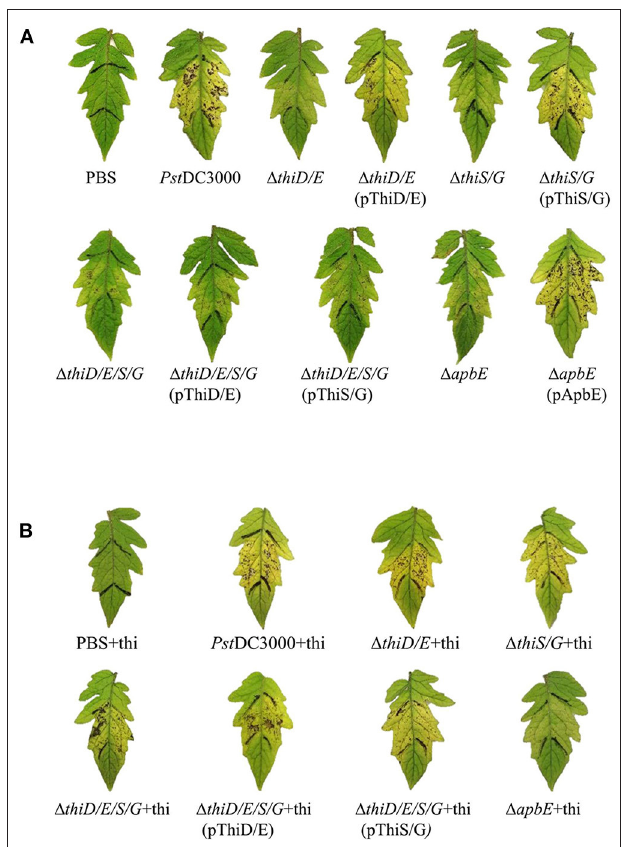
FIGURE 5 | Thiamine-related genes contribute to Pst DC3000 virulence. (A) Tomato leaves inoculated by infiltration with Pst DC3000 wild type and the thiD/E , thiS/G , thiD/E/S/G , apbE mutants, and complementation strains. Phosphate-buffered saline (PBS) was used as a negative control. (B) Pst DC3000 wild type, the thiD/E , thiS/G , thiD/E/S/G mutants, and their corresponding complementation strains with exogenous 100 µ g/ml thiamine inoculated into tomato leaves. Pictures were taken at 7 days postinoculation (dpi). “ + thi:” added exogenous 100 µ g/ml thiamine. Each strain was inoculated onto 10 tomato leaves with a needleless syringe in each experiment. Experiments were repeated three